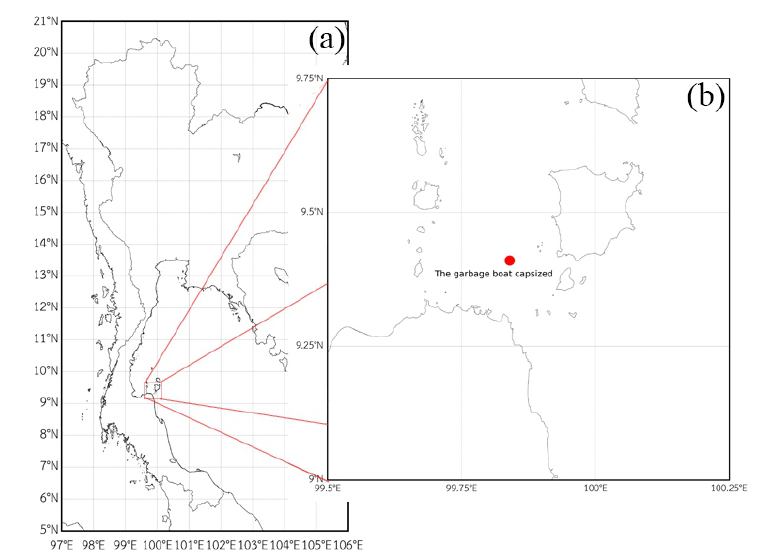
Figure 1. ( a ) Study area in the Gulf of Thailand and ( b ) position of a case study.